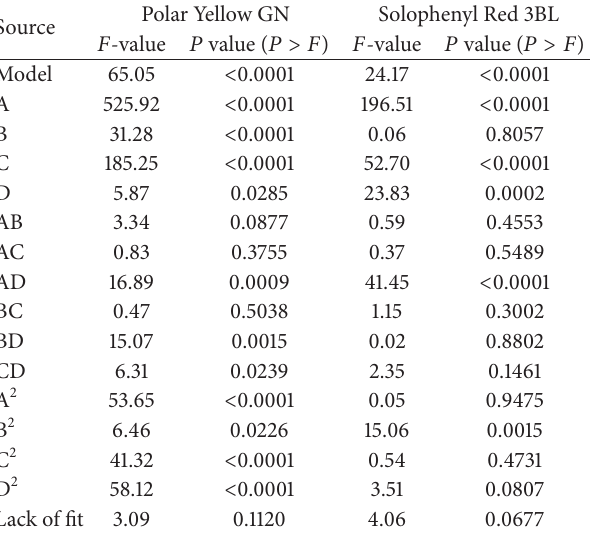
Table 4: Analysis of variance for two acid and direct dyes. Polar Yellow GN Source